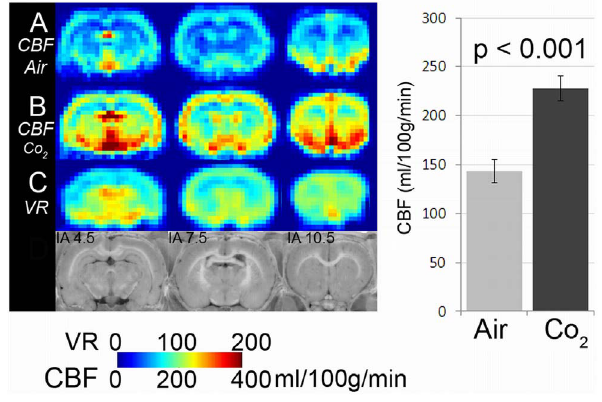
Figure 1. Assessment of vasoreactivity using 5% CO 2 . CBF maps from six healthy animals were averaged. A: averaged CBF map during inhalation anaesthesia with air and B: with 5% CO 2 . C: Vasoreactivity map (VR) obtained by subtracting A from B. D: Anatomical location of brain slices analyzed in MRI with respect to intraaural (IA) line. The graph on the right side displays whole brain CBF values measured with air or CO 2 .